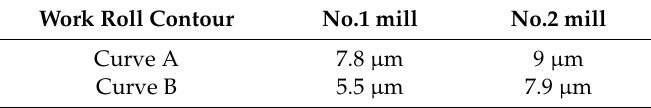
Figure 13. Box diagram of transverse thickness difference of strip under different parameters. Table 6. Statistics of transverse thickness difference of strip.